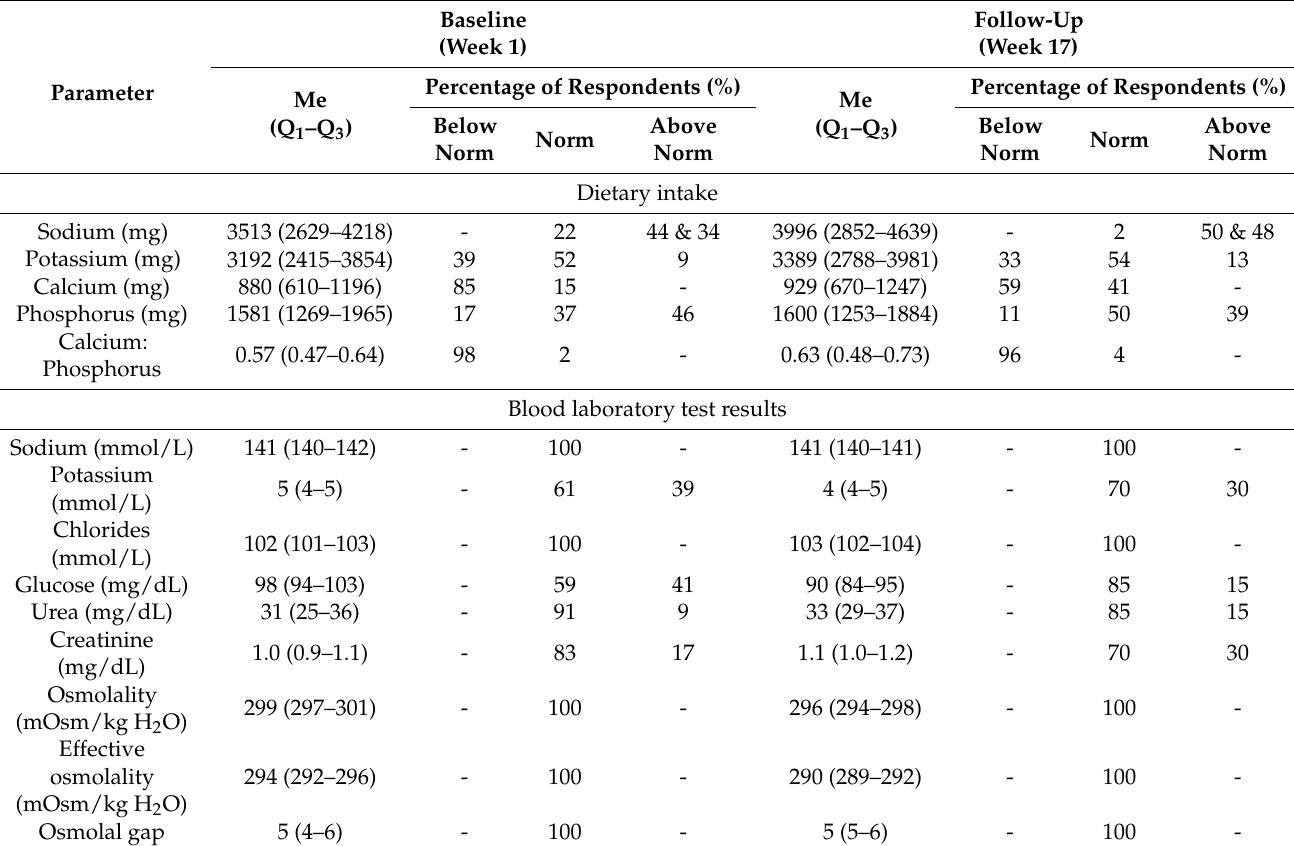
Table 4. Diagnosis of dehydration based on dietary intake and blood laboratory test